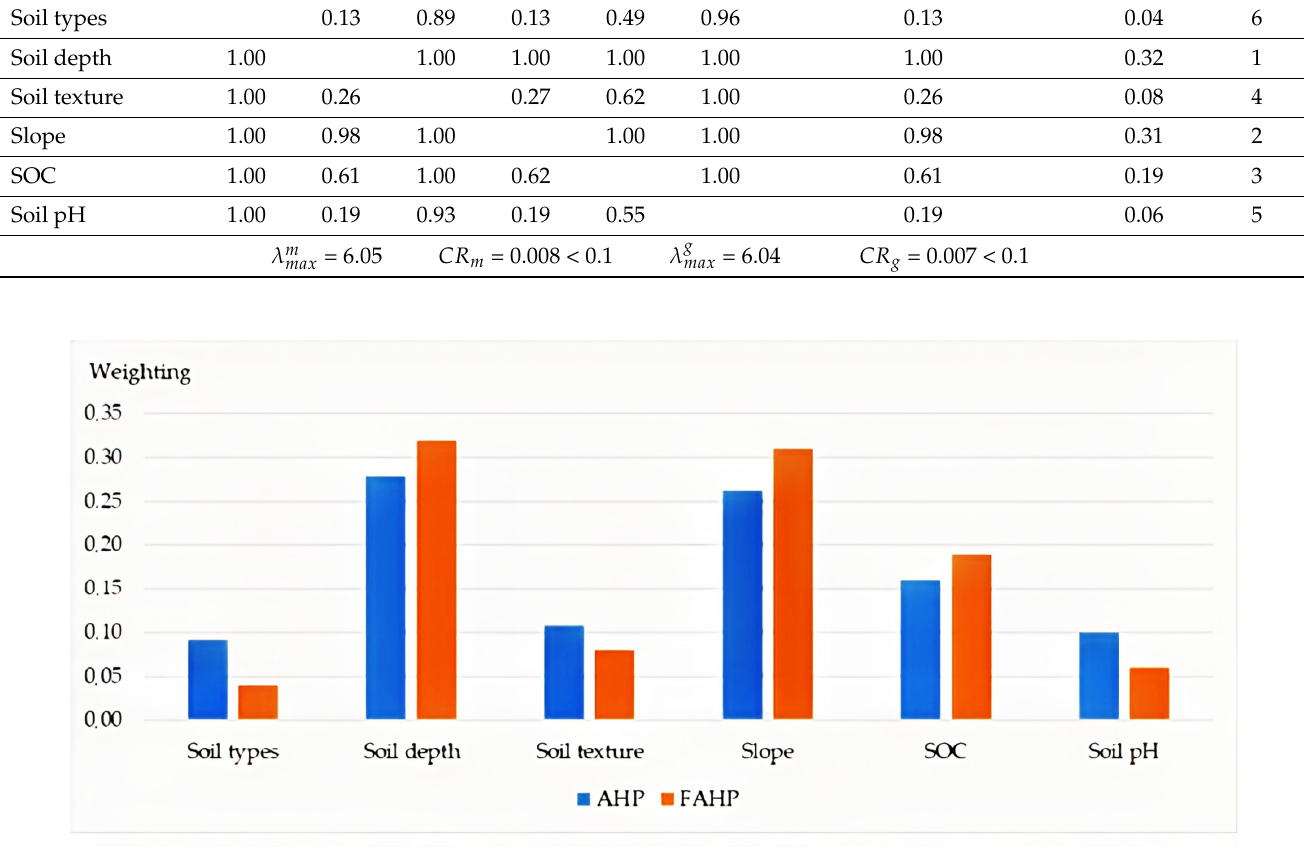
Table 7. The pairwise comparison matrix by FAHP.